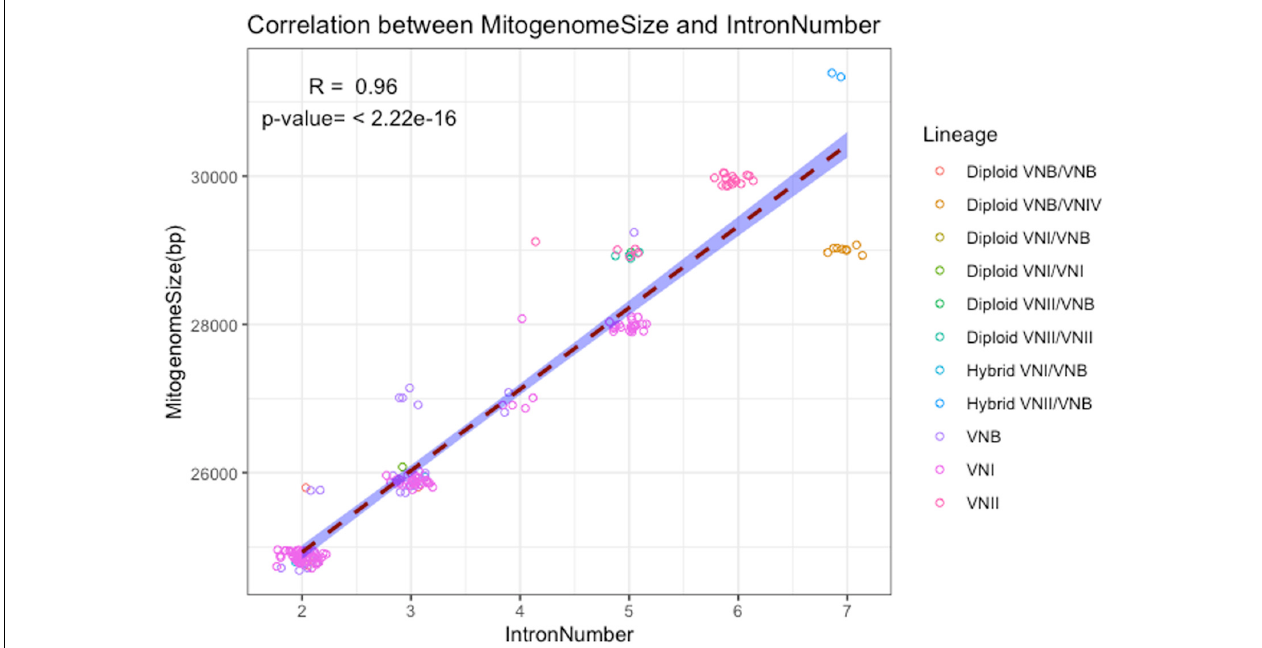
FIGURE 3 | Correlation between mitogenome size and intron number. The regression line and the 95% confidence interval are shown. Random noise was added to points using normal distribution to show the number of data points around each value. The standard deviations given to the X axis (intron number) and the Y axis (mitogenome size) are 0.1 intron and 60 bp